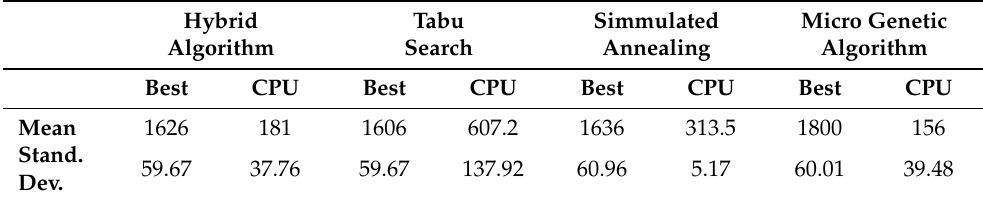
Table 6. Comparison of mean and standard deviation values with a randomly generated solution as an initial solution. Hybrid Simmulated Micro Genetic